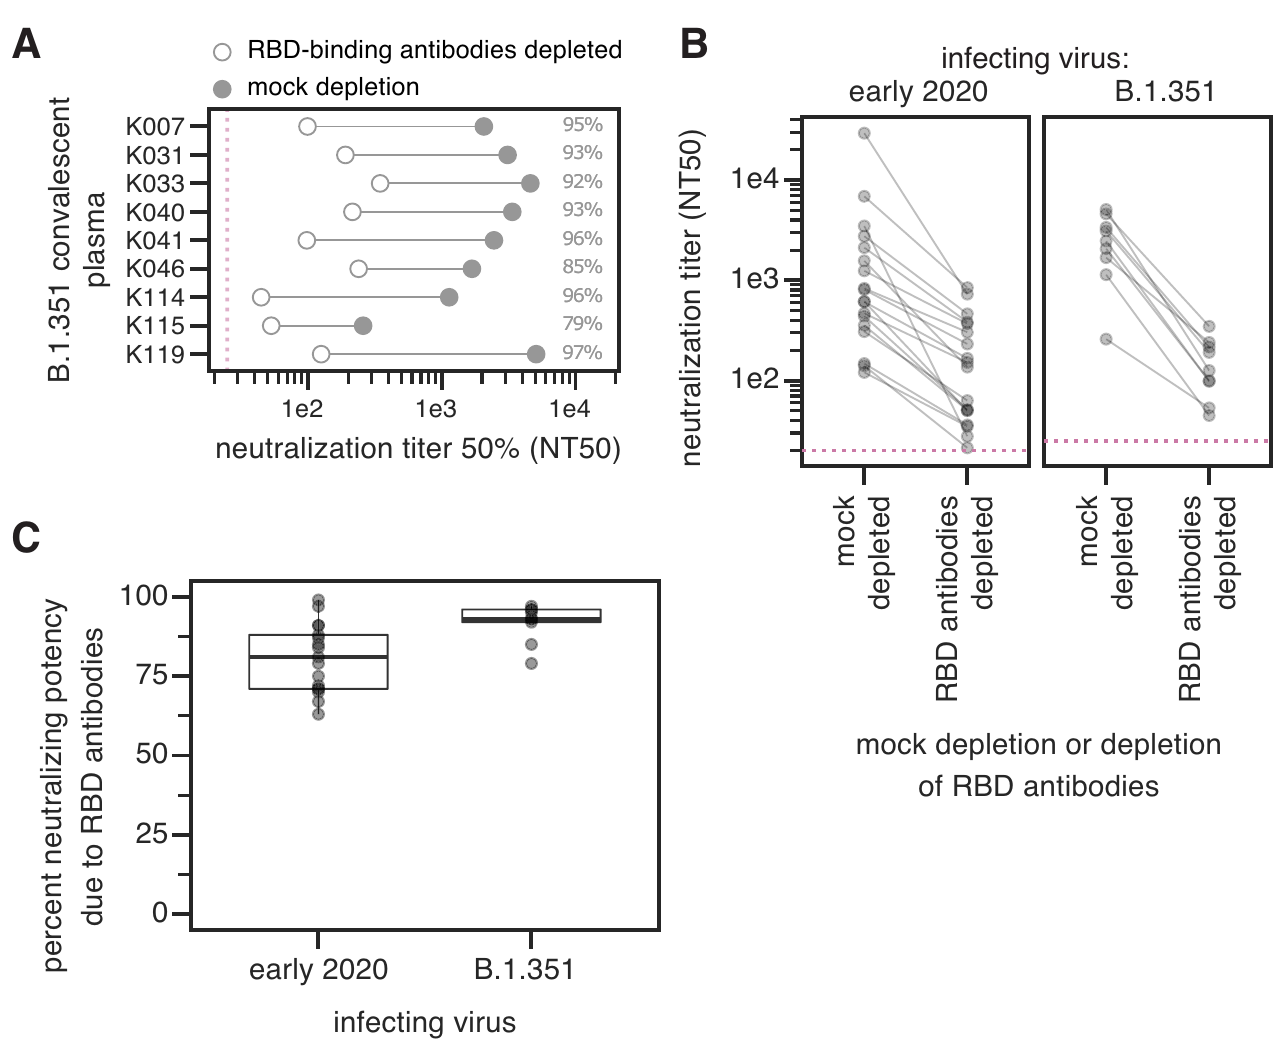
Fig 2. The neutralizing activity of plasma antibodies elicited by B.1.351 infection is heavily focused on the RBD. (A) The neutralizing titer (NT50) of plasmas from B.1.351-infected individuals against B.1.351 spike-pseudotyped lentiviral particles, following mock depletion or depletion of B.1.351 RBD- binding antibodies. (B) Comparison of neutralization titer following mock depletion or depletion of B.1.351 RBD-binding antibodies for early 2020 (n = 17) [28] and B.1.351 convalescent plasmas (n = 9). The pink dashed line in A, B indicates the limit of detection (NT50 of 25 for B.1.351 plasmas, and 20 for early 2020 plasmas). (C) Percent loss of neutralization after removal of RBD-binding antibodies for early 2020 and B.1.351 convalescent plasmas. The difference is not significant (Cox proportional-hazards test, accounting for censoring, p = 0.12). Experiments with B.1.351 infection-elicited plasmas were performed with B.1.351 RBD proteins and spike-pseudotyped lentiviruses, and experiments with early 2020 plasmas were performed with Wuhan-Hu-1 RBD proteins and D614G spike-pseudotyped lentiviruses. The data for the early 2020 viruses are reprinted from [28]. Neutralization titers are in S1 Data and at